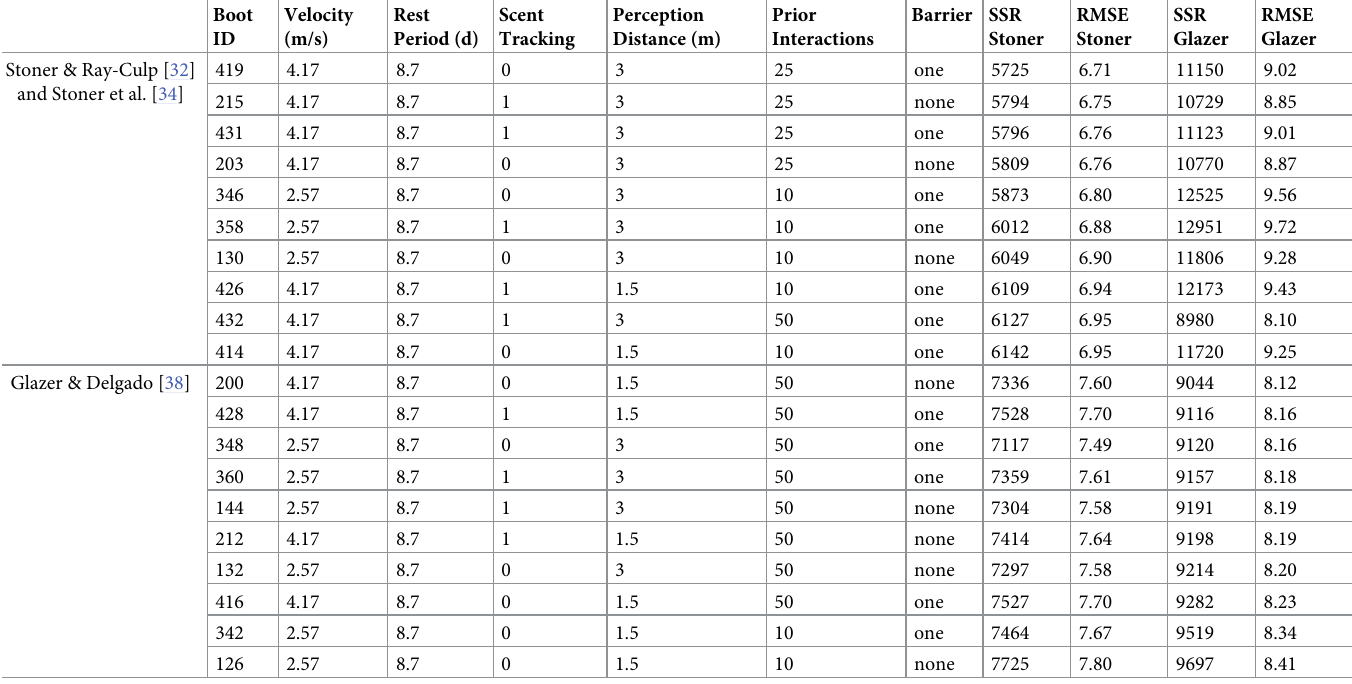
Table 3. Best-fitting